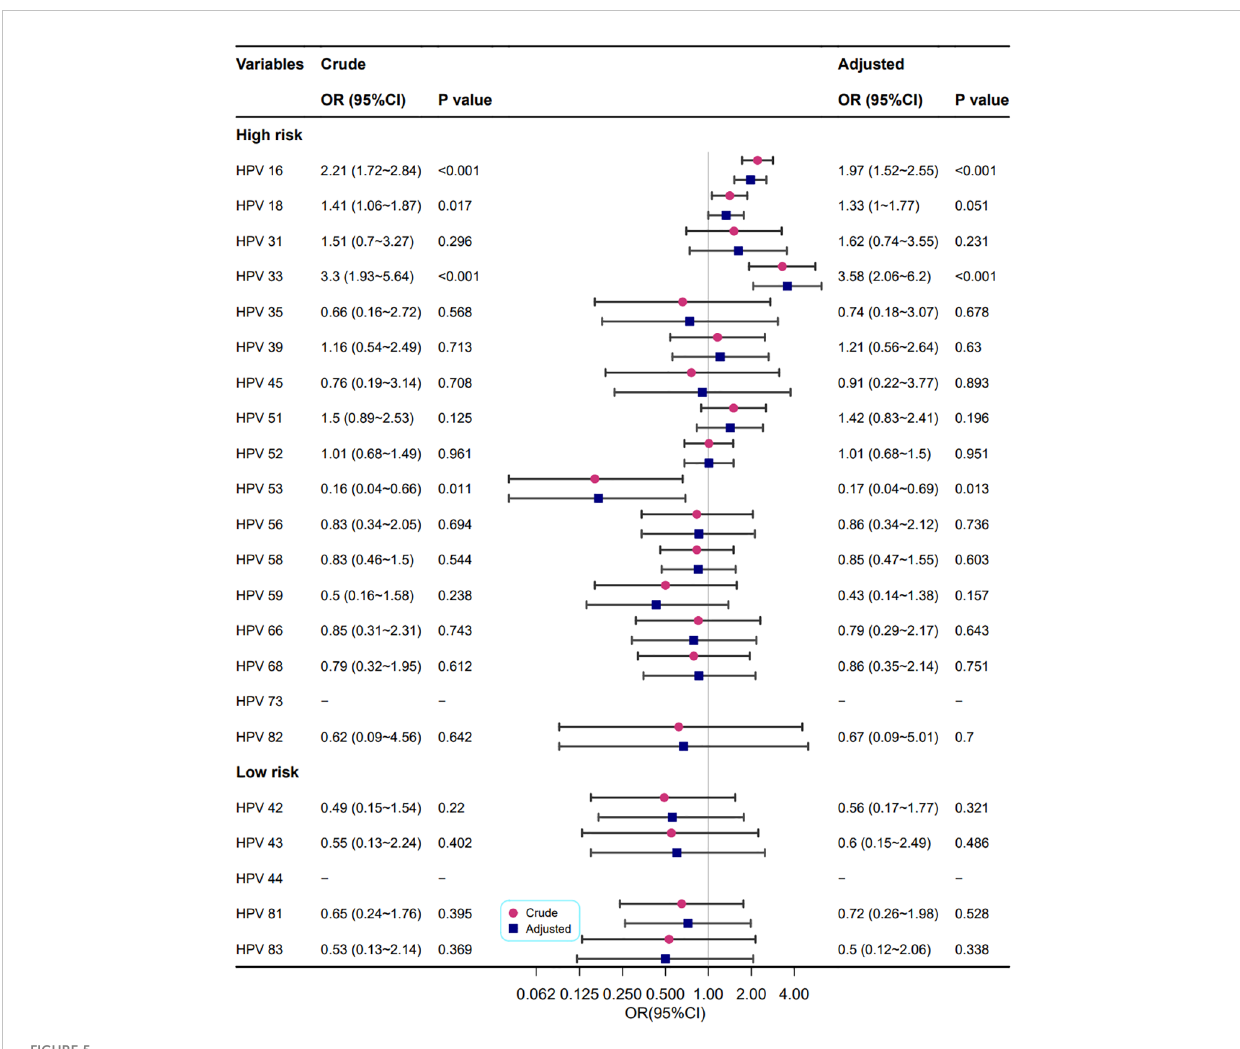
FIGURE 5 Association between different HPV genotypes and cervical vascular mosaic features. Model adjustments for age, gravidity, and